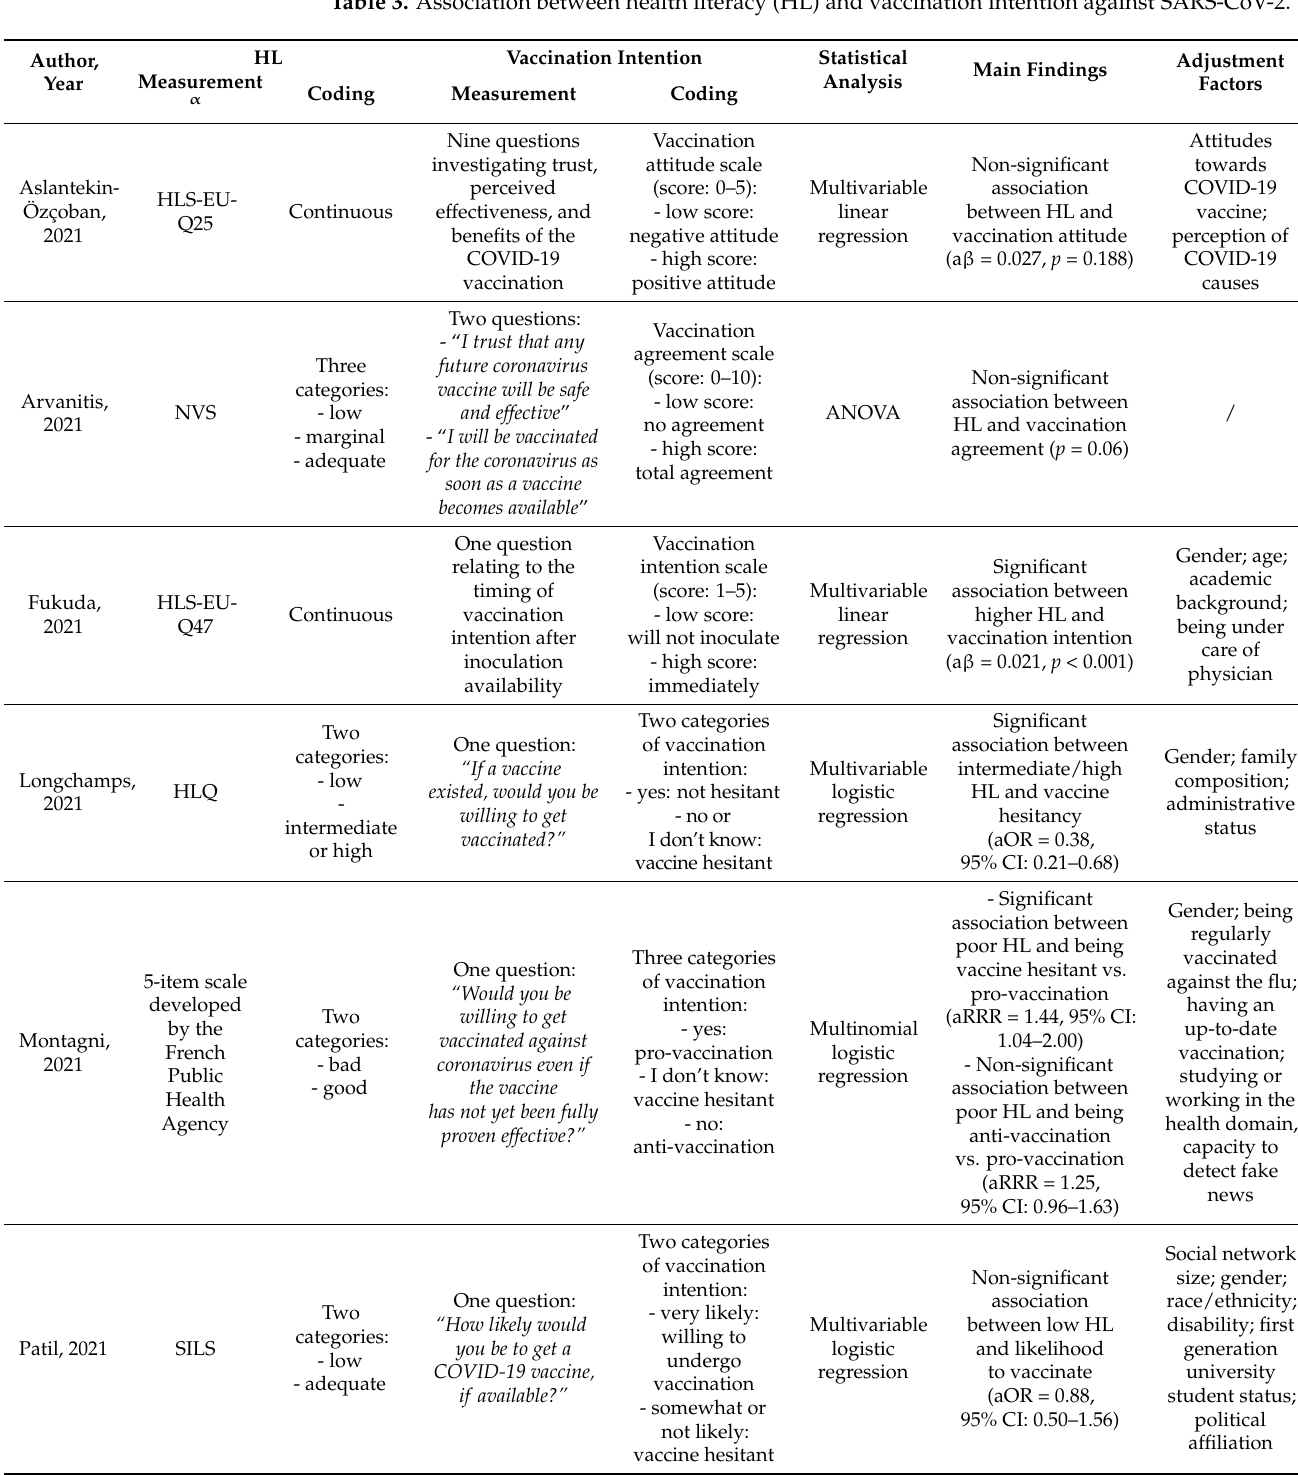
Table 3. Association between health literacy (HL) and vaccination intention against